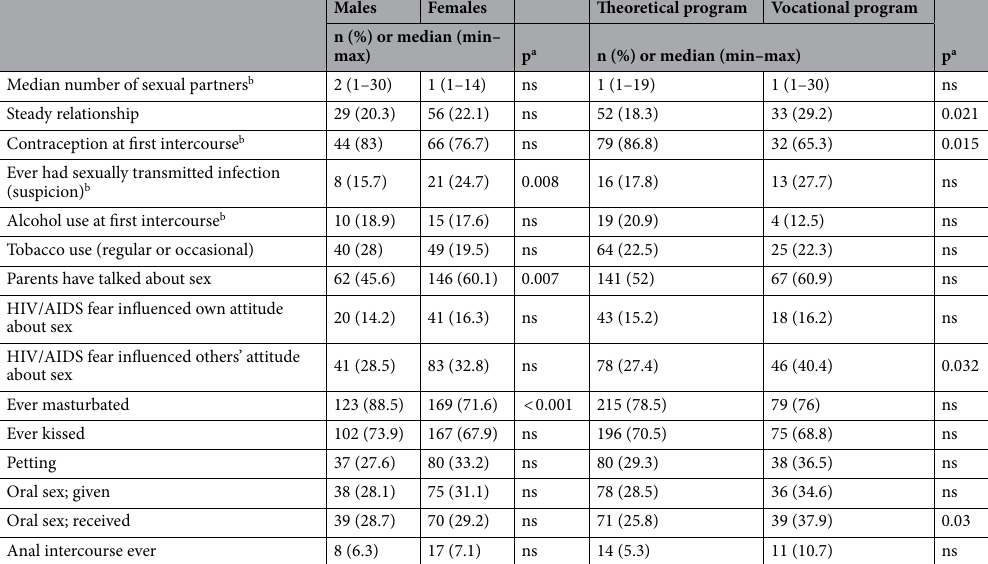
Table 3. Sexual behavior and risk factors across genders and study programs among first-year high-school students. a Pearson chi-square, Fisher’s exact test or Mann–Whitney. b Calculated among those who have had intercourse.